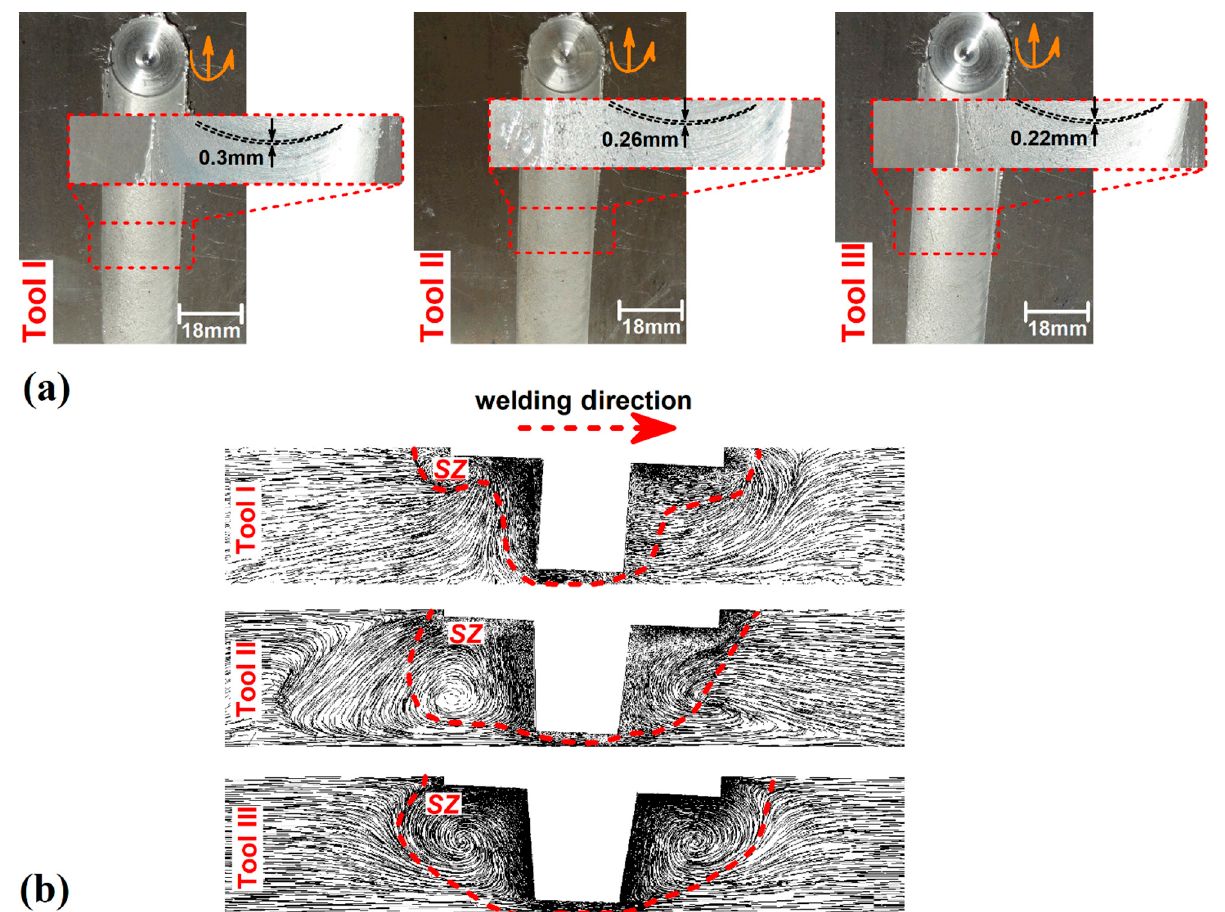
Figure 6. ( a ) surface materials flow of FSWed sample with Tool I, II and III, ( b ) longitudinal section from simulation results of internal flow of joint that FSWed with Tool I, II and III.